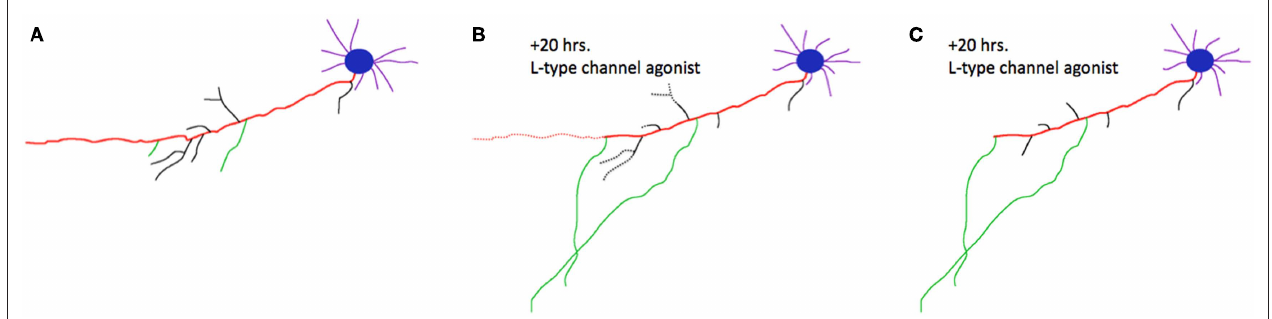
Figure 1 | Competitive axon remodeling accelerated by an L-type calcium channel agonist. (A) Tracing of a cortical neuron grown in dissociated tissue culture. The primary axon is shown in red; branches are shown in black, or green for emphasis. Blue, cell body; purple, dendrites. (B) After 20 h in a L-type calcium